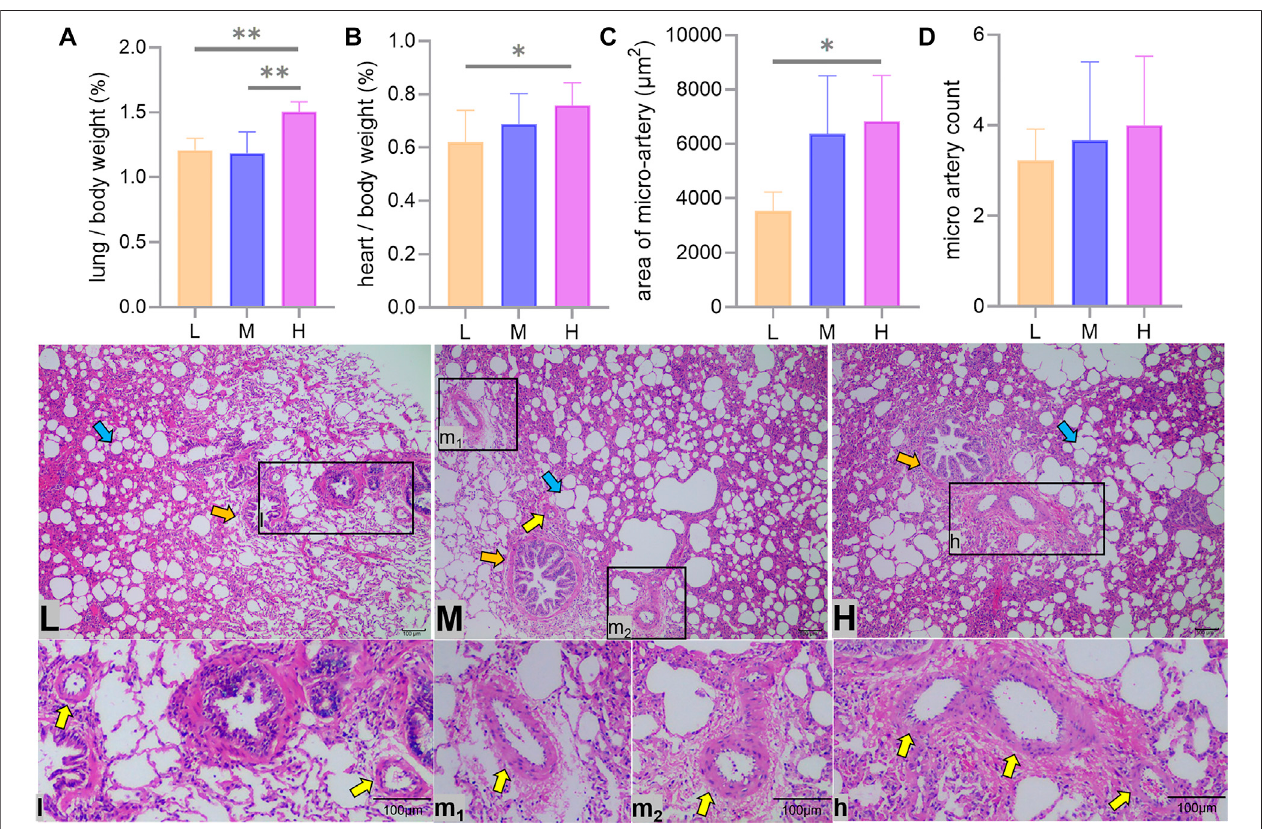
FIGURE2| Heartand lungtobodyweight ratioand lunghematoxylin – eosinstaining.Differencesinlung (A) andheart (B) asapercentage ofbodyweight,average area (C), andnumber (D) ofarteriolesata100x fi eldofviewbetweenlow(L),middle(M),andhigh(H)altitudesandarteriolesunderopticalmicroscopeareshown.*and** indicate signi fi cant ( p < 0.05) and extremely signi fi cant ( p < 0.05) differences between different altitudes, respectively; yellow arrows indicate arterioles, orange arrows indicate terminal bronchioles, and blue arrows indicate alveoli.